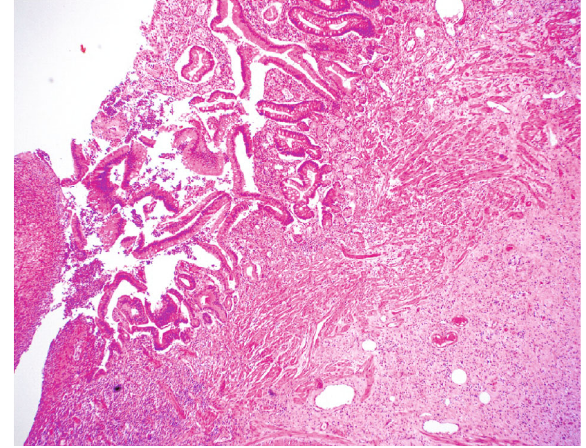
Figure 4: H&E from stricture site with tumor in view (bottom right) at 40 magni fi cation (4x).